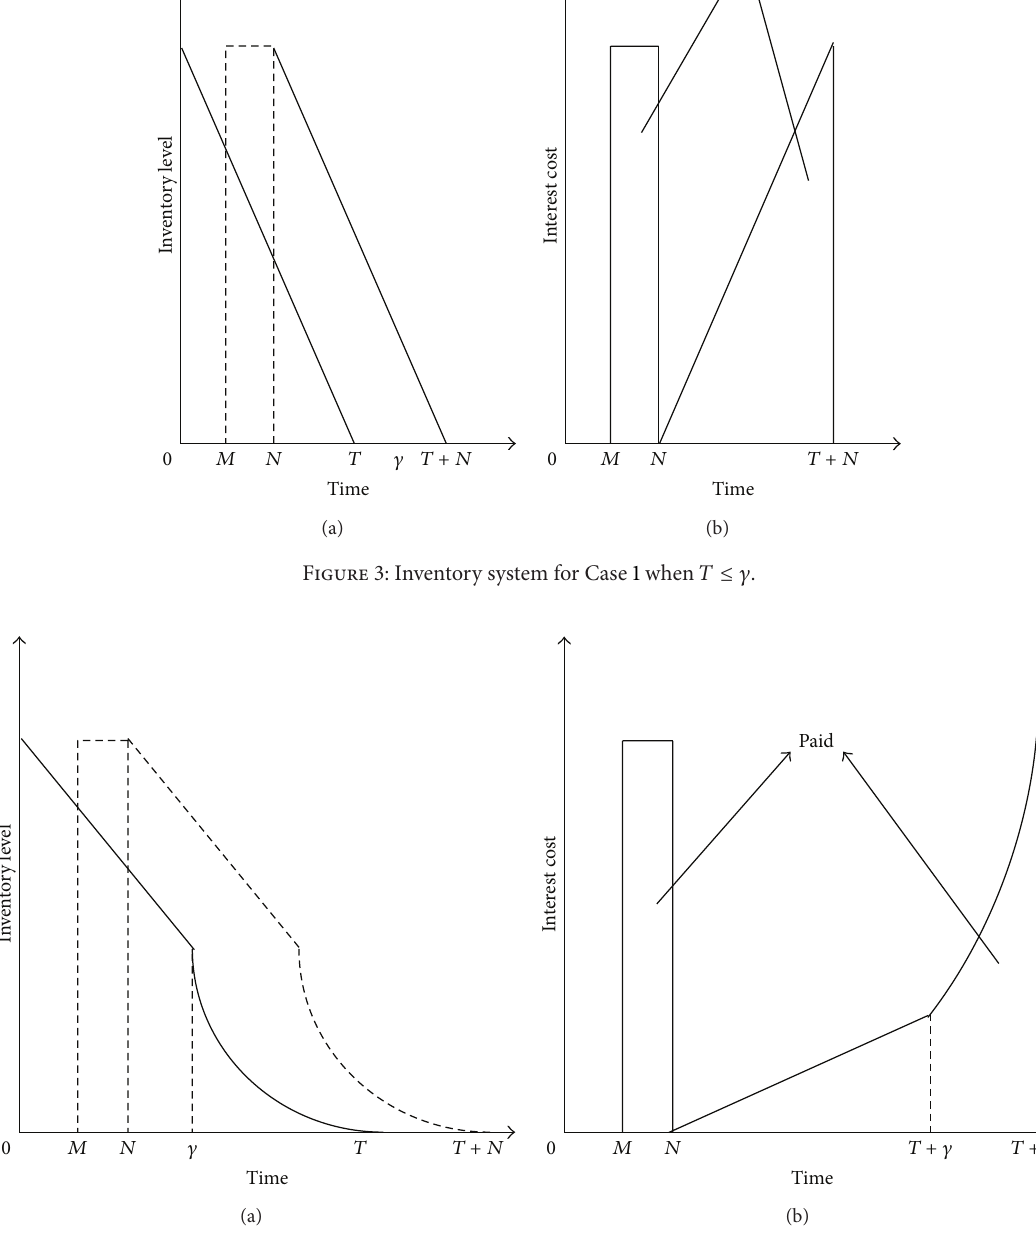
Figure 4: Inventory system for Case 1 when 𝑇 ≥ 𝛾